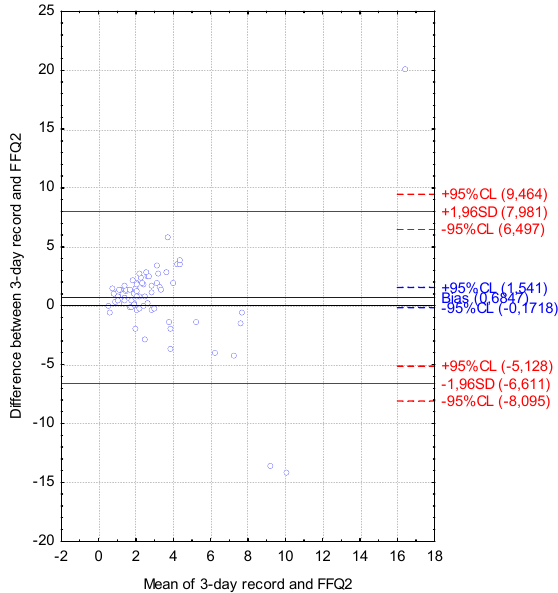
Figure 5. Bland ‐ Altman plot comparing VIDEO ‐ FFQ2 with the three ‐ day dietary record for Vitamin D daily intake (Bland ‐ Altman index of 4.0%); FFQ2—VIDEO ‐ FFQ filled out six weeks after FFQ1. The Bland ‐ Altman plot comparing FFQ2 with FFQ1 of Vitamin D daily intake is presented in Figure 6. The mean absolute difference of Vitamin D intake was observed to amount to − 0.013. The interval from − 5.787 (lower agreement limit) to 5.761 (upper agreement limit) was obtained for the LOA after adding a ±1.96 ‐ fold standard deviation. The number of individuals observed to be beyond the LOA value was 73 out of 75, corresponding to the Bland ‐ Altman index of 2.7%. Nutrients 2016 , 8 , 0000